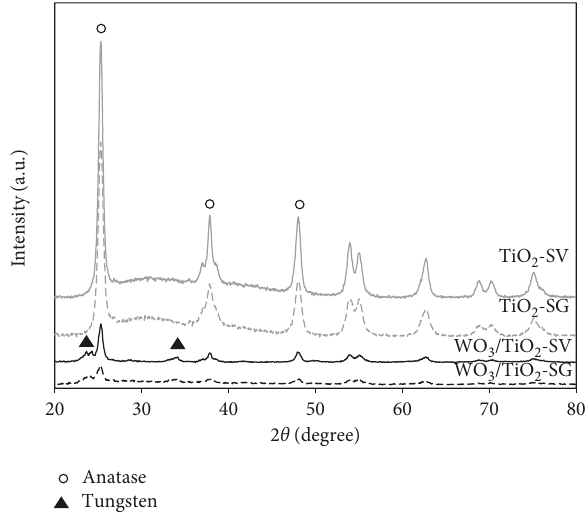
Figure 1: X-ray powder diffraction patterns of supports and